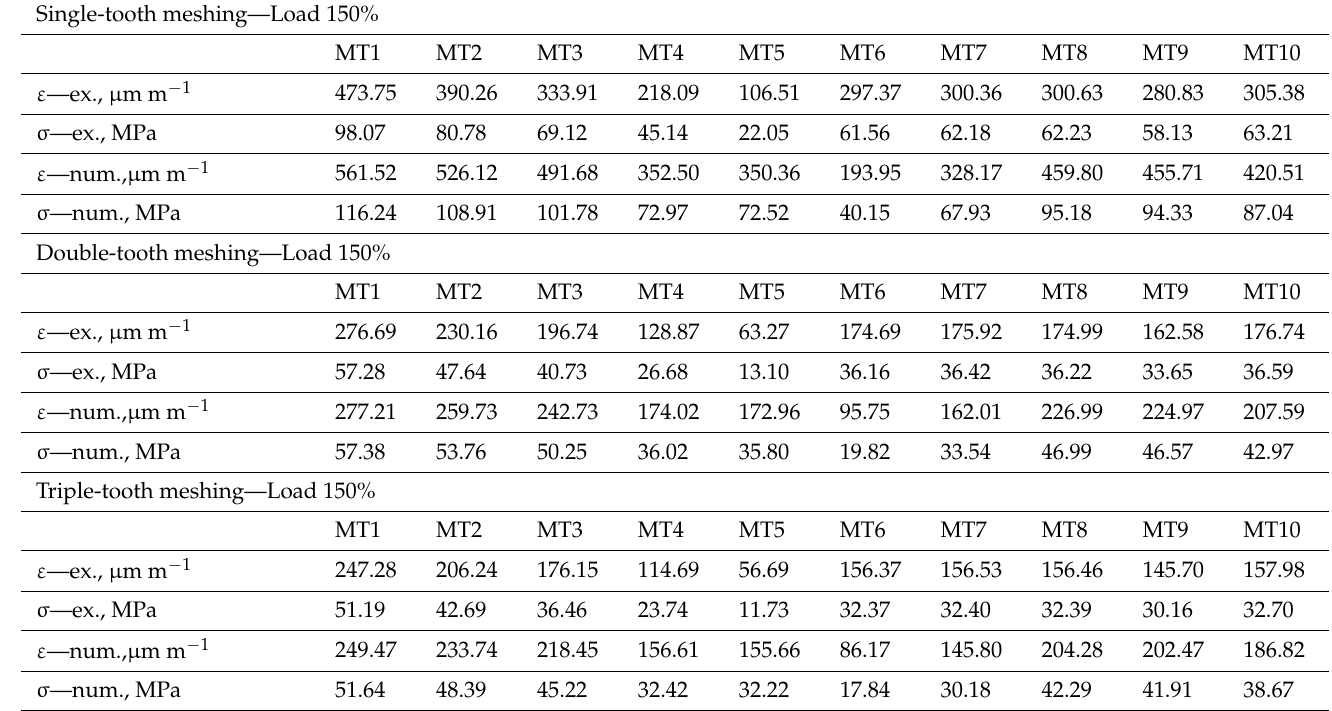
Table 4. Comparative results obtained using the finite element method and experimental